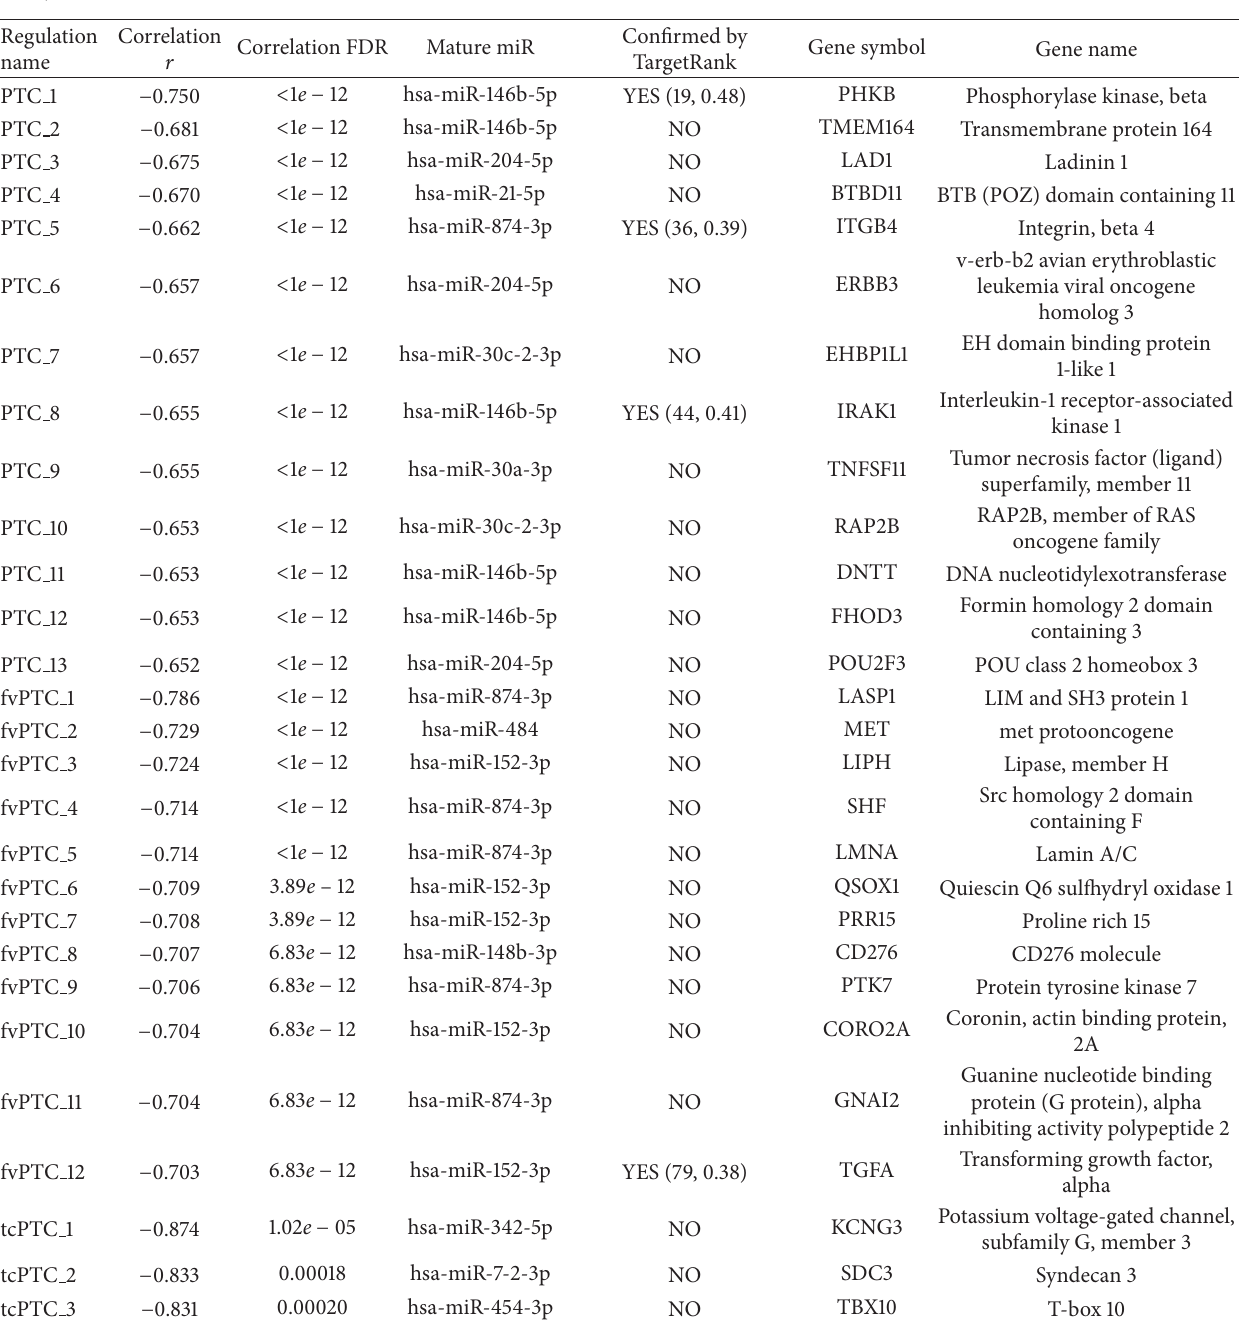
Table 1: Selection of 10 top scoring putative miRNA regulations in PTC, fvPTC, and tcPTC. Selected Spearman correlations of mRNAs and miRNAs were calculated independently in cPTC (321 samples), fvPTC (99 samples), and tcPTC (35 samples) datasets. All shown correlations were predicted by two used prediction tools: miRanda and TargetScan as putative miRNA regulations. Top 10 from each type of thyroid cancer (cPTC, fvPTC, and tcPTC) were ranked by correlation coefficient value and 10 lowest correlations are shown for each dataset (cPTC, fvPTC, and tcPTC). In columns from left, “regulation name,” assigned name of correlation; “correlation 𝑟 ,” correlation coefficient value (Spearman); “Correlation FDR,” DR corrected 𝑝 value of correlation; “mature miRNA,” mature miRNA name; “confirmed by TargetRank,” stating that if regulation is confirmed by TargetRank (rank and score in the parenthesis); “gene symbol,” HGNC symbol of gene in correlation; and “gene name,” HGNC official full